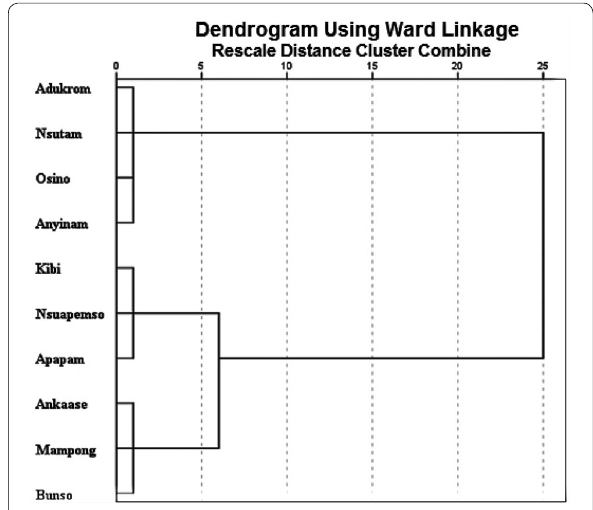
Fig. 2 Dendrogram displaying clustering of the various settlements within the Birim River